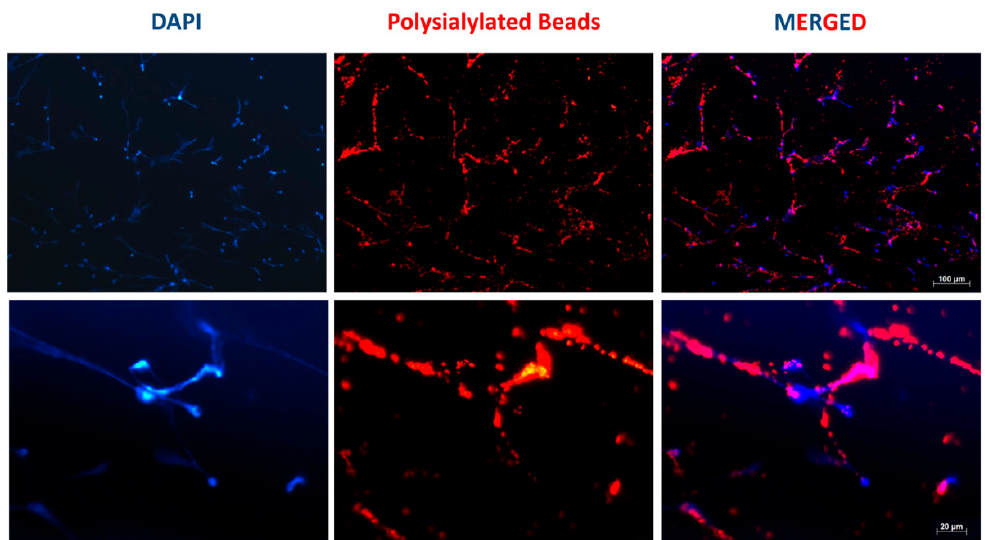
Figure 1. Polysialylated particles accumulating on the neutrophil extracellular trap (NET) fibers of bovine neutrophils. The neutrophils were isolated and stimulated with phorbol myristate acetate (PMA) and ionomycin to induce the formation of the NETs, and red fluorescent polysialylated particles were added. DNA staining was performed using 4 ′ ,6-diamidino-2-phenylindole (DAPI) (blue). Scale bars: 100 and 20 µm.